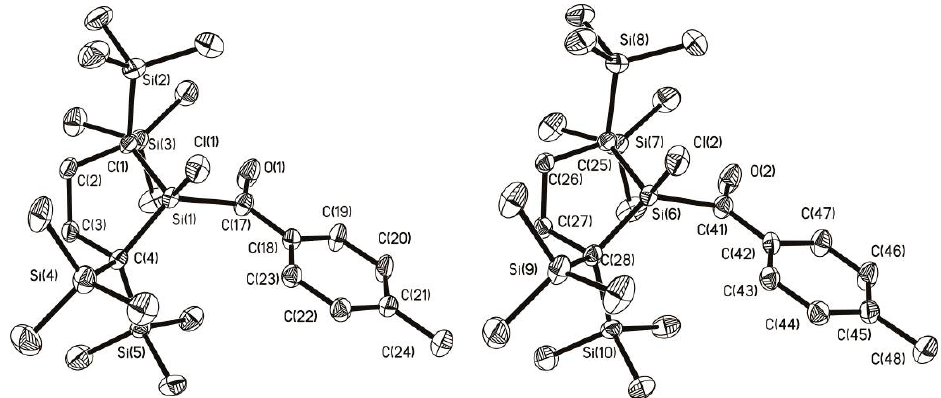
Figure 2. ORTEP drawing of the independent molecules in 3b . (Hydrogen atoms are omitted for clarity. Thermal ellipsoids are shown at the 30% probability level.) Selected bond lengths (Å) and angles (°): Si(1)–C(1) 1.883(4), Si(1)–C(4) 1.898(4), Si(1)–C(17) 1.940(4), Si(1)–Cl(1) 2.1003(14), C(17)–